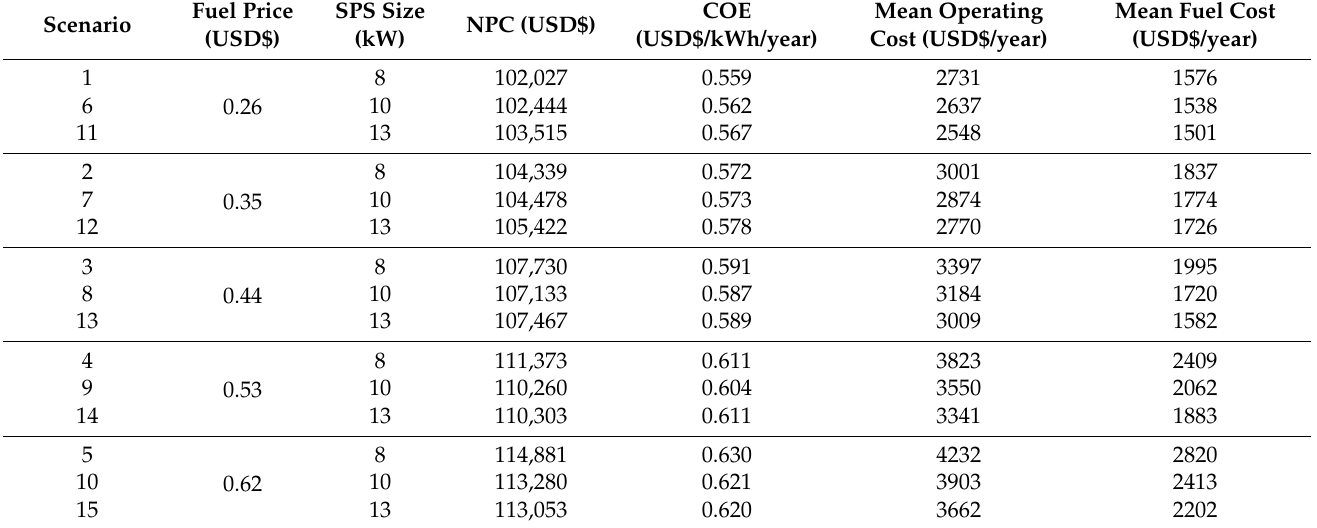
Table 4. Costs of the scenarios over the 15-year project period.